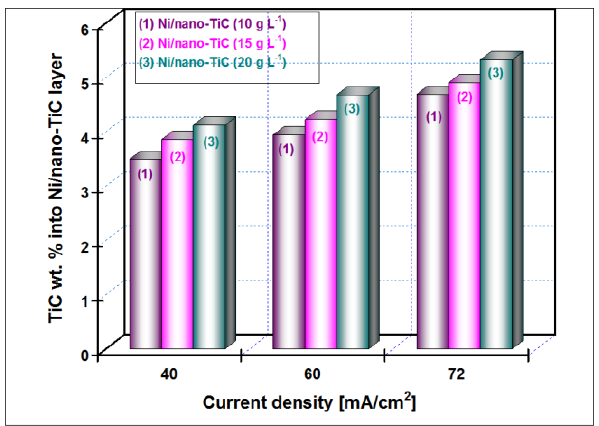
Figure 7. The degree of nano-TiC inclusion into nickel matrix depending on the current density at the time of codeposition of 15 min and different concentration of TiC nanoparticles added to the nickel electrolyte.